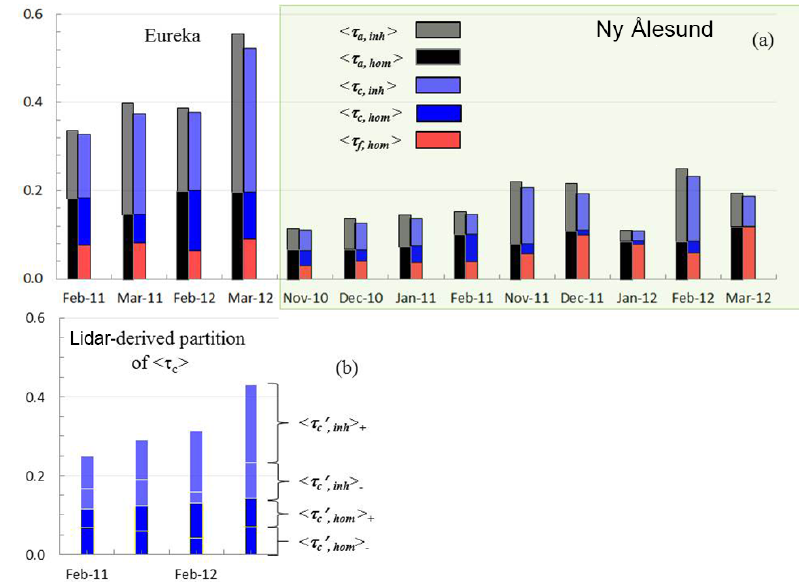
Figure 3. (a) Comparison of temporal and spectral cloud screening (partitioned according to Eqs. (4) and (5), respectively) for monthly AOD averages computed for Eureka and Ny-Ålesund during the polar winters of 2010/2011 and 2011/2012. (b) Partitioning of lidar-derived coarse-mode optical depths into homogeneous and inhomogeneous contributions above and below (“ + ” and “ − ”) the nominal maximum altitude of low-altitude ice crystal layers ( h LIC ) at